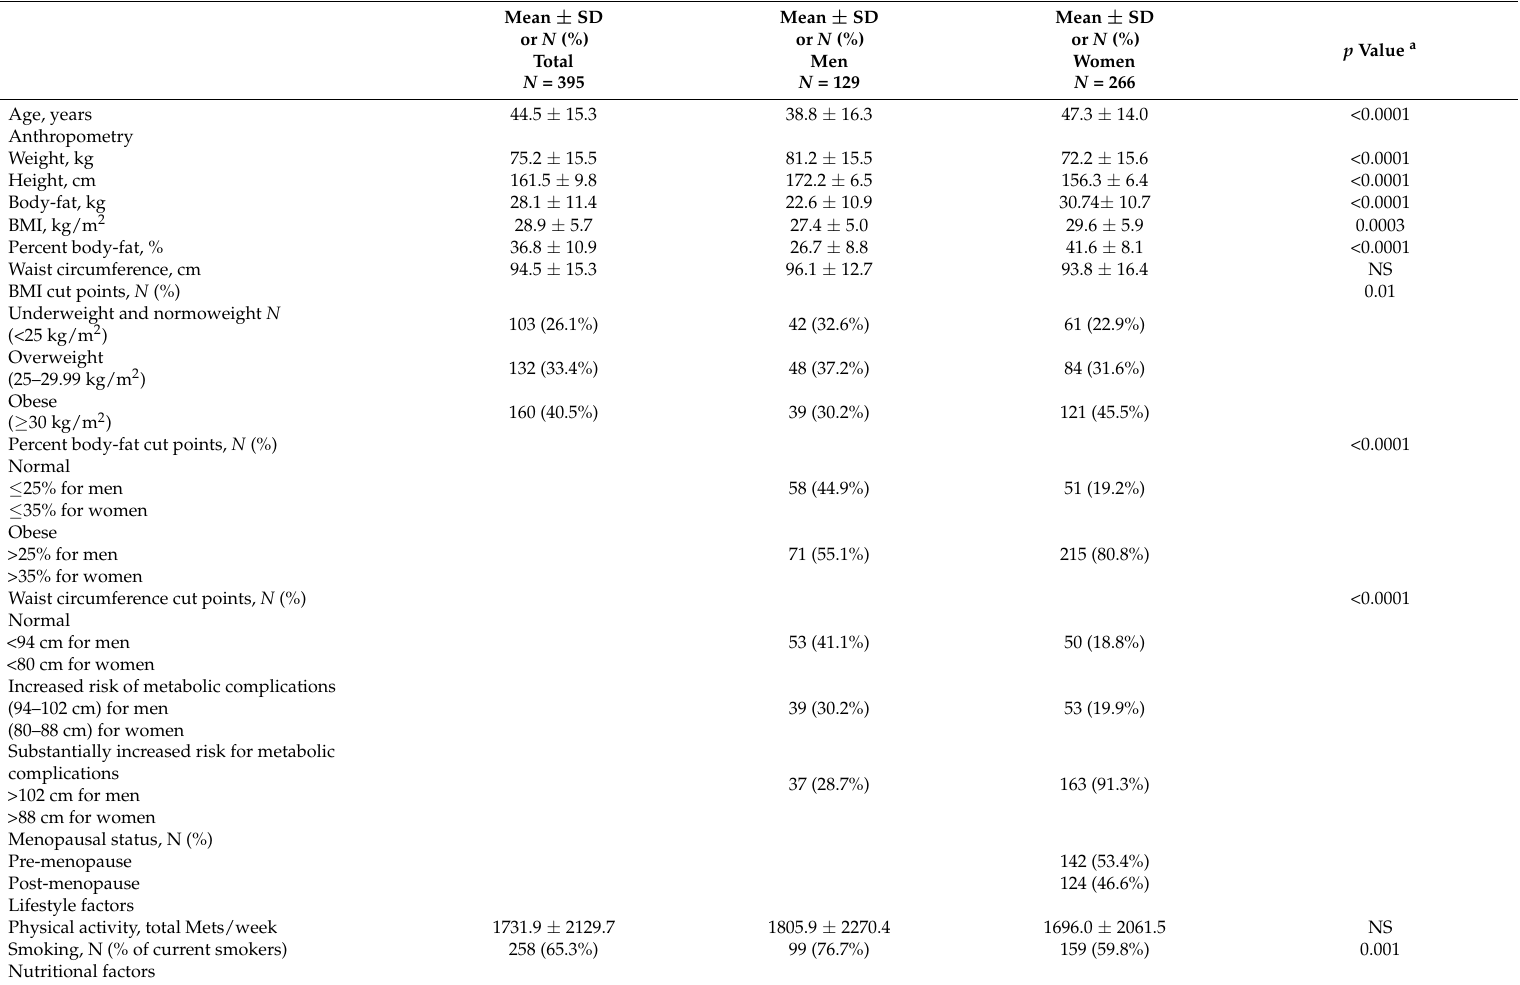
Table 1. Baseline characteristics of the studied